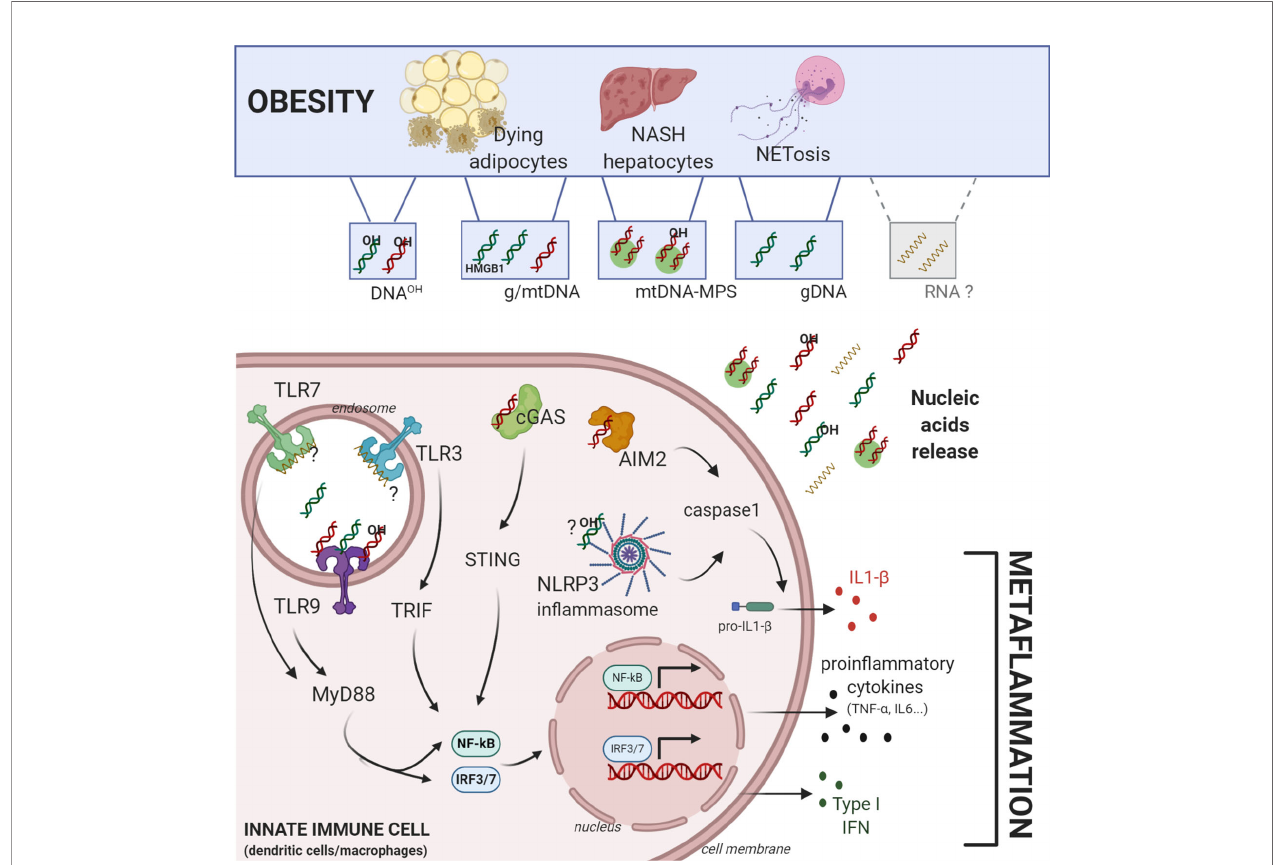
FIGURE 1 | Central role of self-nucleic acids in obesity-mediated meta fl ammation. Obesity induces an accumulation of different sources and forms of self-nucleic acids (NA). Genomic-, mitochondrial, oxidized-DNA (OH-DNA) and potentially RNA can be released in aberrant amounts during obesity by dying adipocytes, NASH hepatocytes, or NETosis. Self-NA can activate cytosolic or endolysosomal pathogen recognition receptors in macrophages or dendritic cells such as Toll-Like- Receptor 3/7/9, cGAS-STING pathway, AIM2 and NLRP3 in fl ammasomes. Their activation induces in situ production of i) proin fl ammatory cytokines (IL6, TNF- a … ) through the activation of NF- Κ B, ii) type I interferon through the transcription factors IRF3/7, and iii) IL1- b , through the caspase 1 activation, all of which contribute directly to obesity mediated-meta fl ammation. Figure was created with